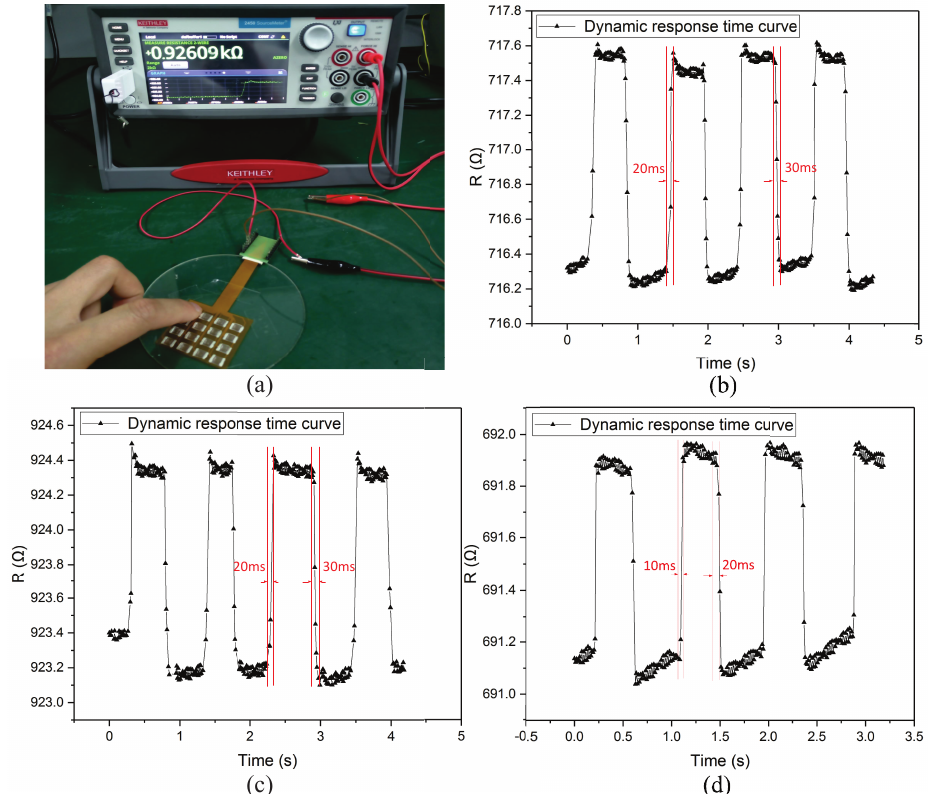
Figure 10. ( a ) Photograph of the measurement of the dynamic characteristic; ( b – d ) Measurement results of the sensing